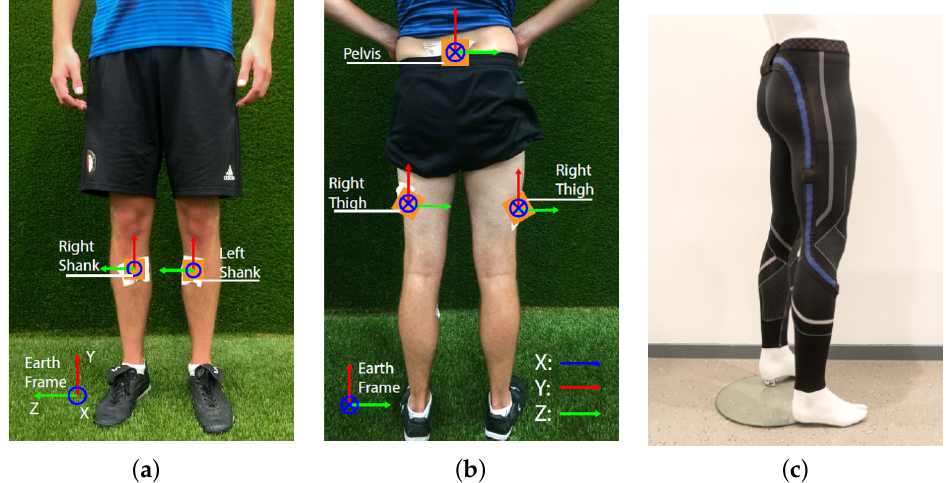
Figure 1. ( a , b ): Location of IMUs in experiments. Taken from [28]. ( c ): New sensor tights prototype with fully embedded sensors. Taken from